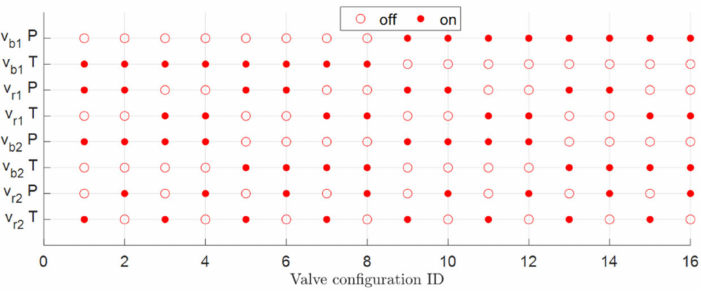
Figure 2. Valve positions for 16 unique valve configurations.